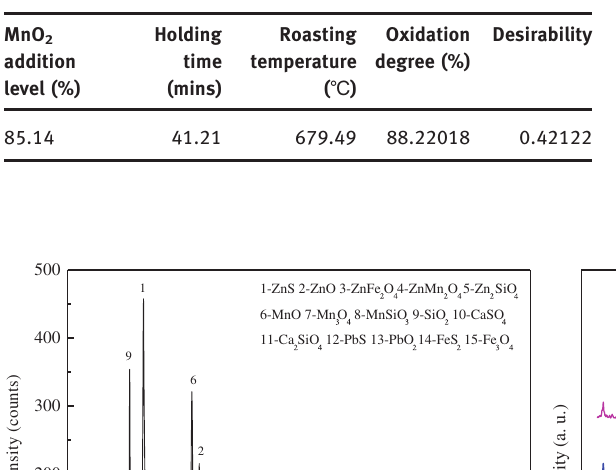
Table 4: Optimization process parameters of the regression model.